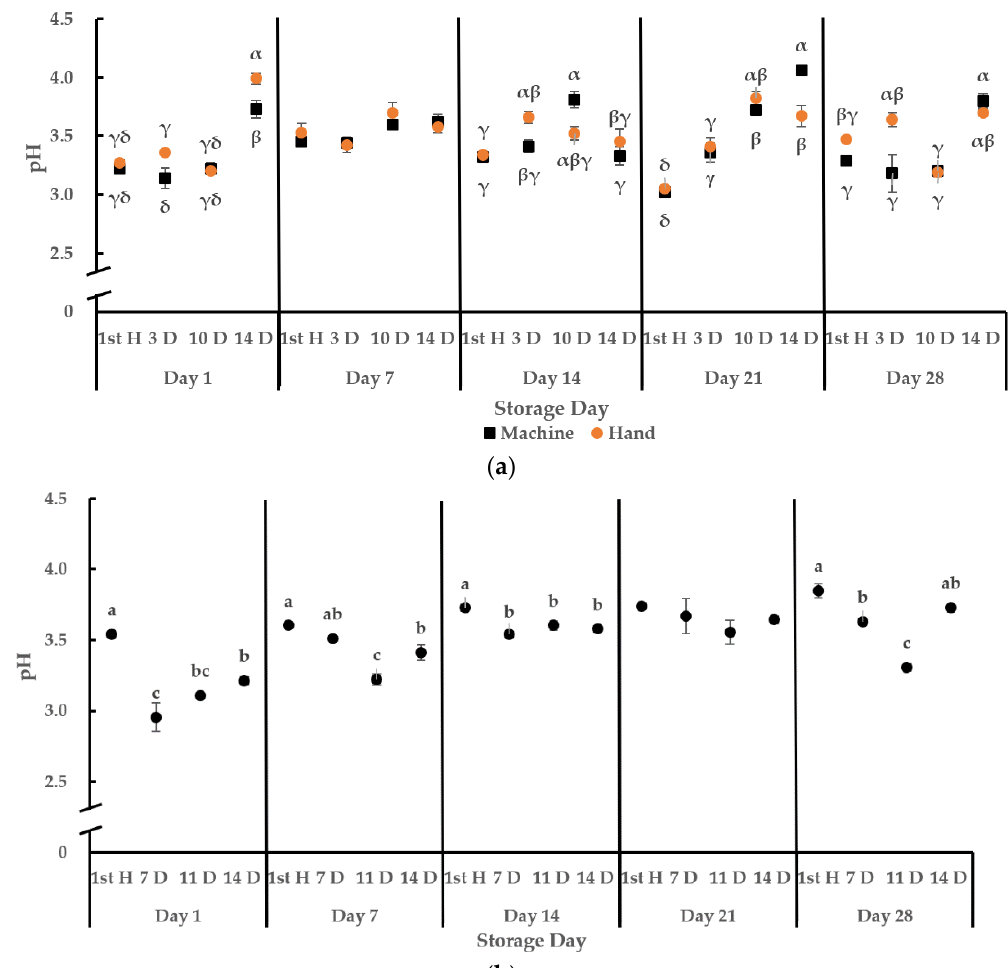
Figure 5. Juice pH of ‘Liberty’ northern highbush blueberry in 2019 ( a ) and 2020 ( b ) at 1, 7, 14, 21, and 28 days after packing. Fruits were harvested at 3-, 10-, and 14-day harvest intervals in 2019 and at 7-, 11-, and 14- day harvest intervals in 2020. The first harvest was the baseline from which interval treatments were established. Fruits were harvested by hand or using a modified over-the-row (OTR) harvester with patent-pending elastomeric polymers installed on catching surfaces in northwest Washington, USA. Values are mean ± SE (a: N = 3; b: N = 6). Different Greek letters indicate significant differences ( p < 0.05) among both hand and machine harvested fruit on each evaluation day due to interaction effects of harvest method and interval. Different lowercase letters indicate significant differences ( p < 0.05) due to intervals on each evaluation day. Hand and machine harvesting data are combined due to lack of harvest method and interaction effects in 2020 ( b